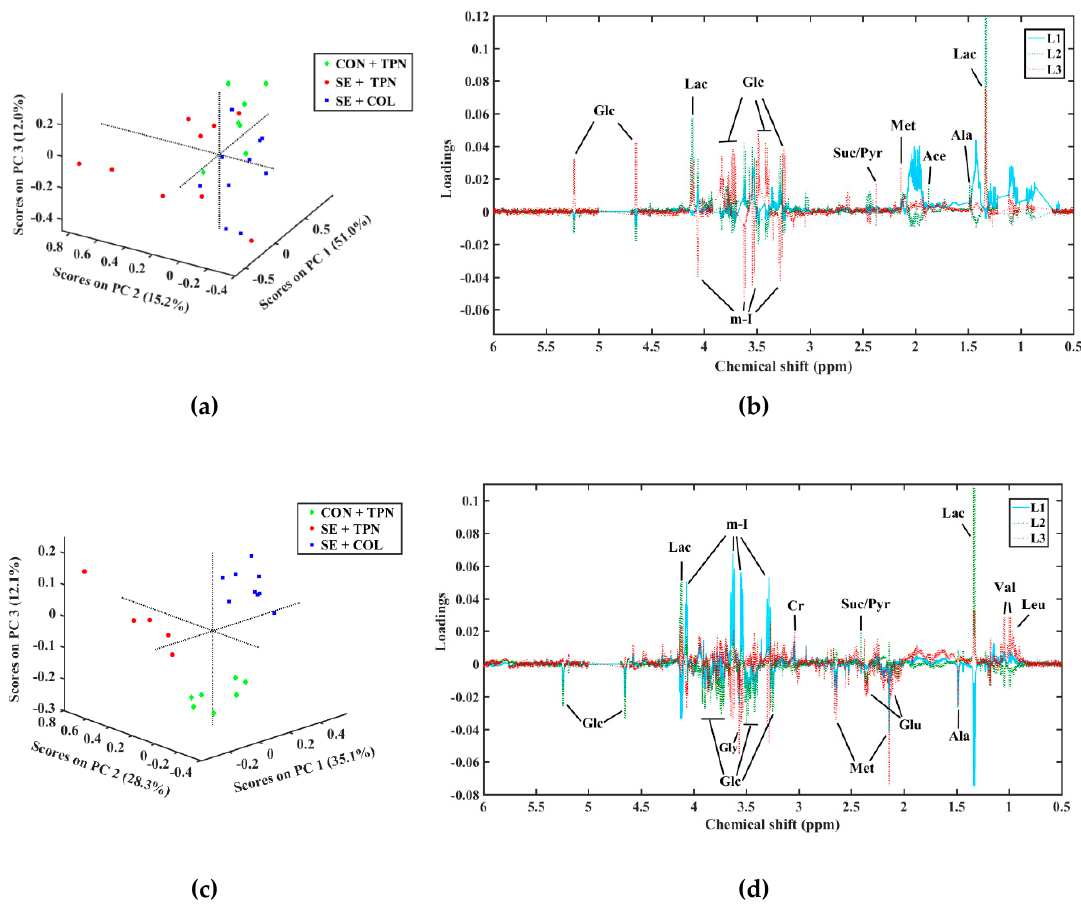
Figure 3. Principal component analysis (PCA) score and loading plots of the NMR data of ( a , b ) CSF and ( c , d ) plasma samples. CON + TPN (green diamond) represents the control group, SE + TPN (red circles) represents the infected group by Staphylococcus epidermidis (SE), and SE + COL (blue squares) represents the colostrum (COL) supplementation group. In the loading plots: Ace: acetate; Ala: alanine; Cr: creatine; Glc: glucose; Glu: glutamate; Gly: glycine; Lac: lactate; Leu: leucine; Met: methionine; m-I: myo -Inositol; Pyr: pyruvate; Suc: succinate; Val: valine. L1, L2, and L3 are the first, second, and third loadings, respectively.